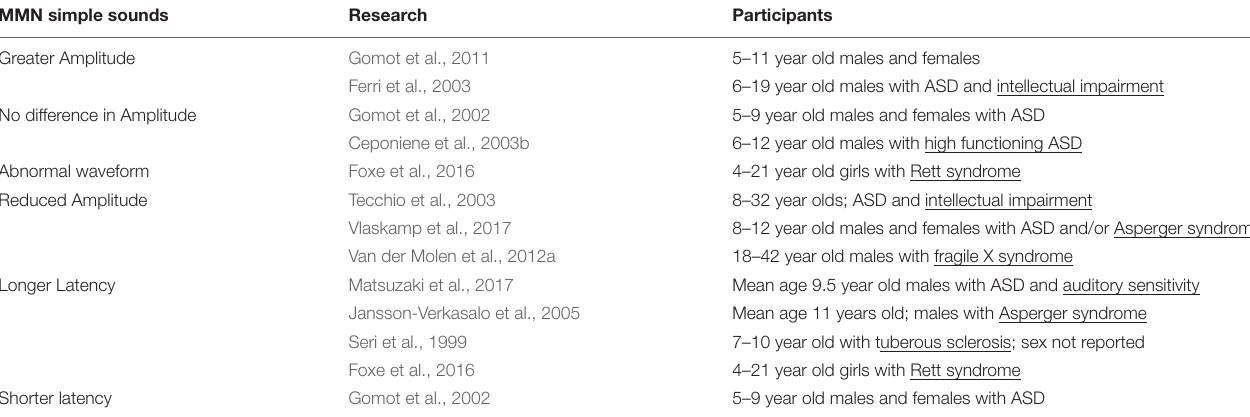
TABLE 3 | MMN peak amplitude and latency in response to simple sound